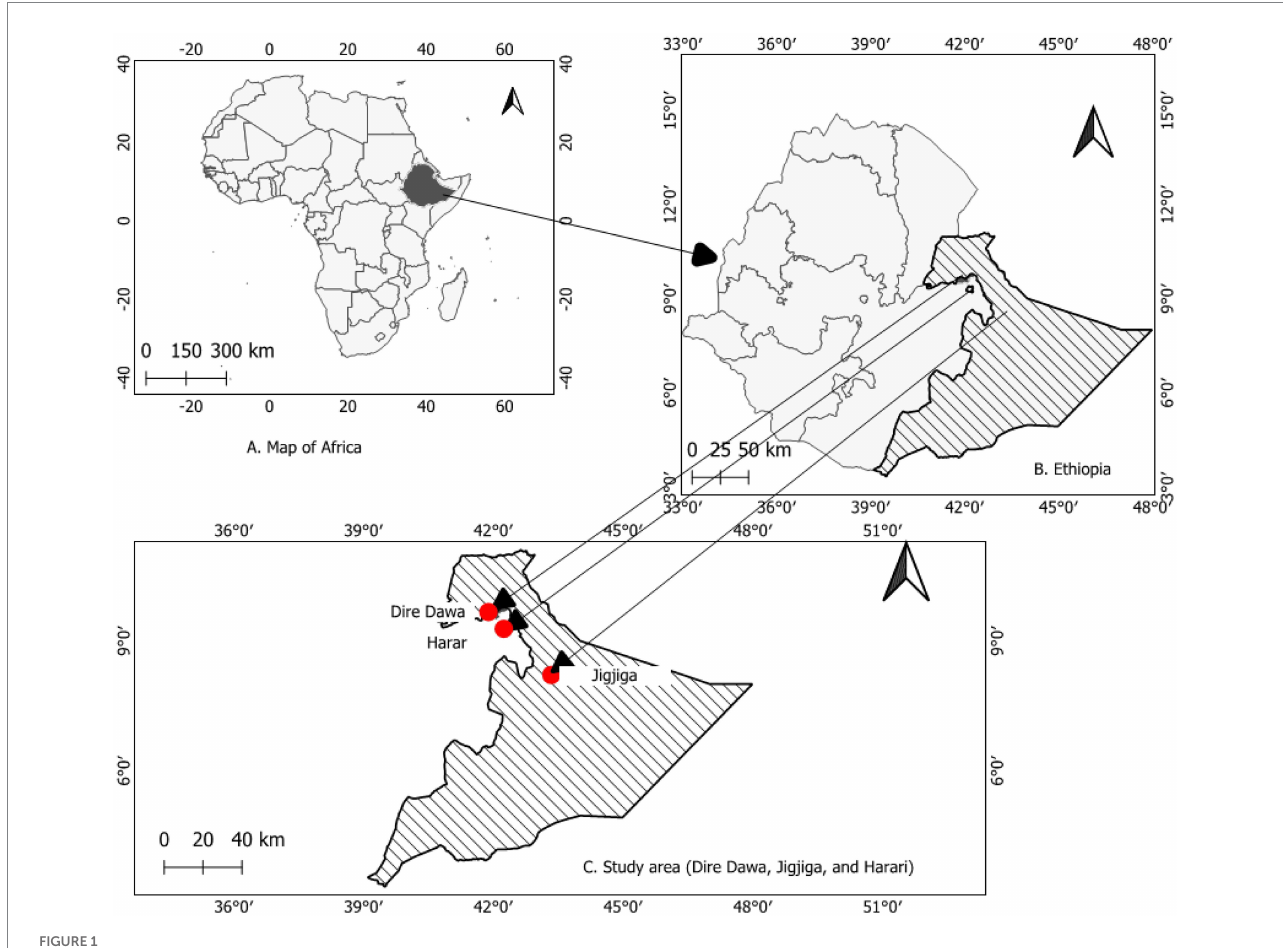
FIGURE 1 Map of study areas (Extracted using QGIS